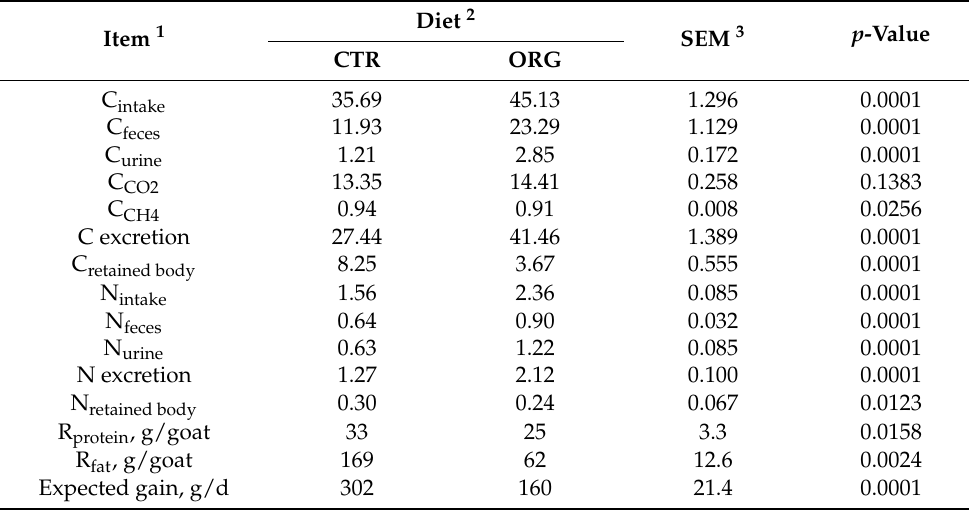
Table 6. Daily balance of carbon and nitrogen (g/kg de BW 0.75 ) of Murciano-Granadina dried goats ( n = 10) by the type of diet.